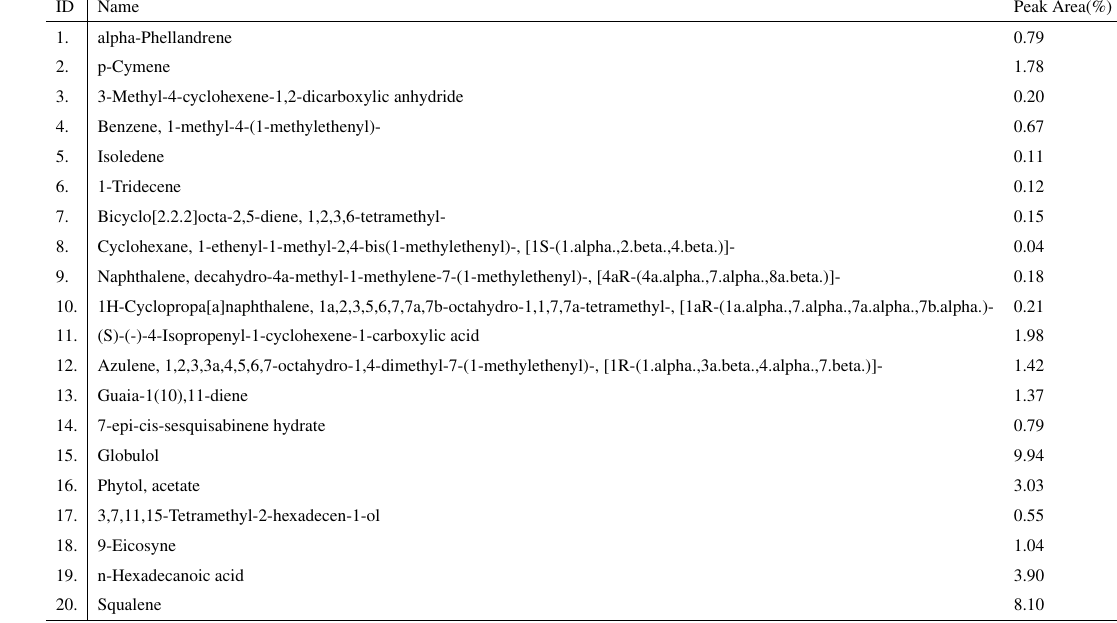
Table 9. Chemical constituent detected appear in the GC-Mass chromatogram in ethanol extract of Kafure leaves and area percentage of